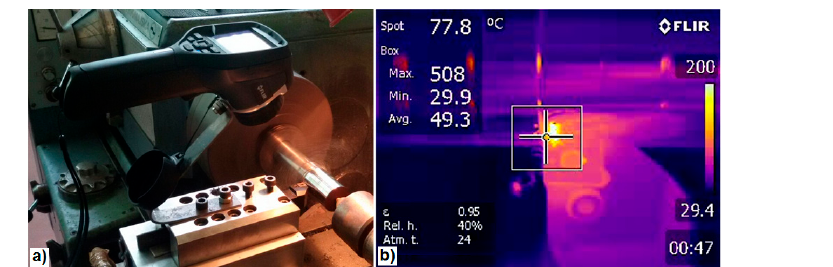
Figure 1. Experiment setup: ( a ) a view of the thermal camera when measuring, and ( b ) a thermal imaging with measurement position.